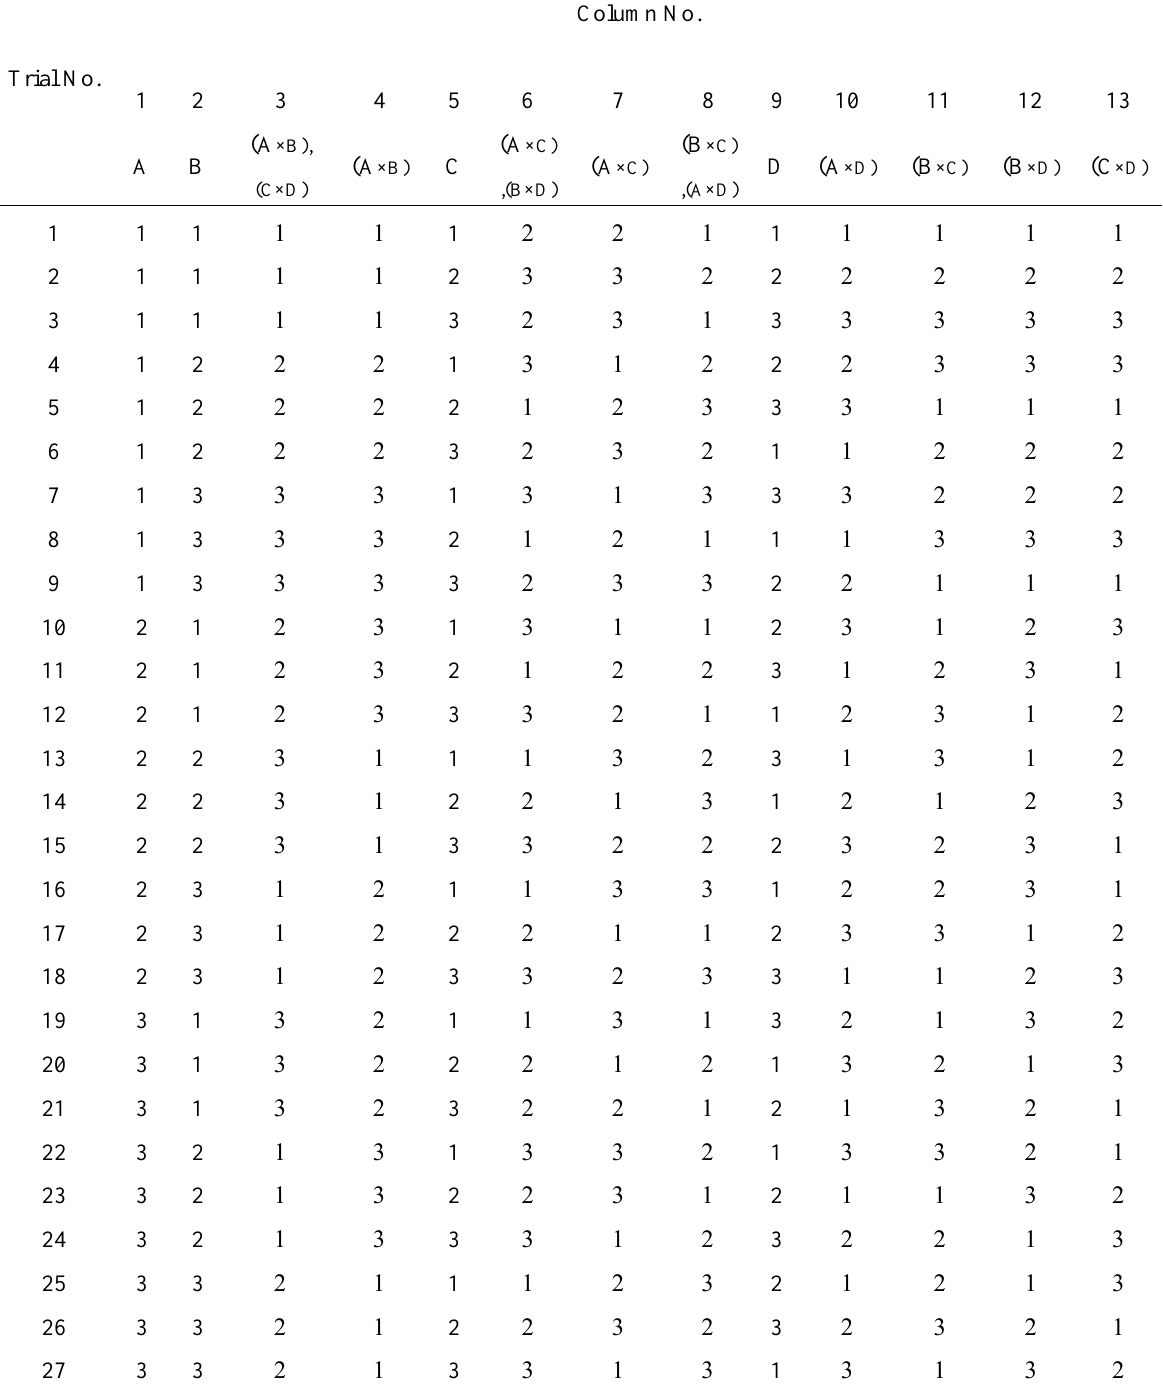
Table 2. L27 Orthogonal array with factors and their